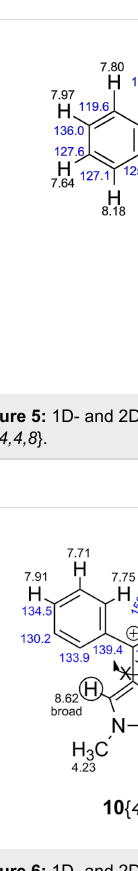
Figure 6: 1D- and 2D-based NMR assignments for methylium-PF 6 salt 10 { 4,4,11 }.